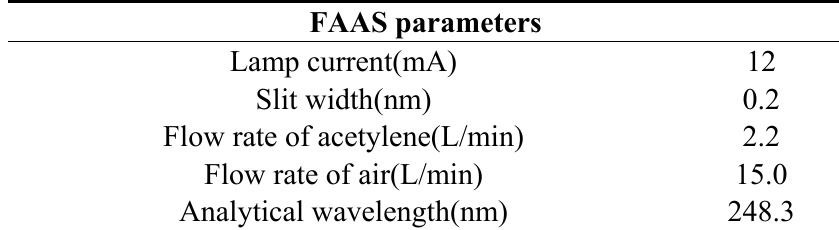
Table 4. FAAS operating